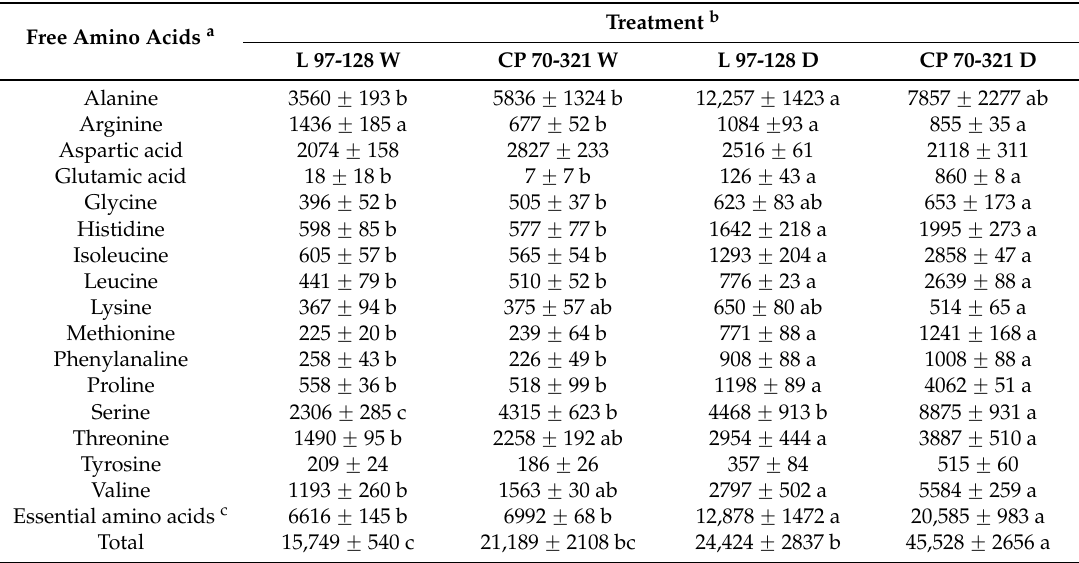
Table 1. Mean ( ˘ SE) picomoles of free amino acid per microliter of sugarcane stalk juice in two cultivars, L 97-128 and CP 70-321, that were well watered or drought stressed in a greenhouse [69]. Free Amino Acids